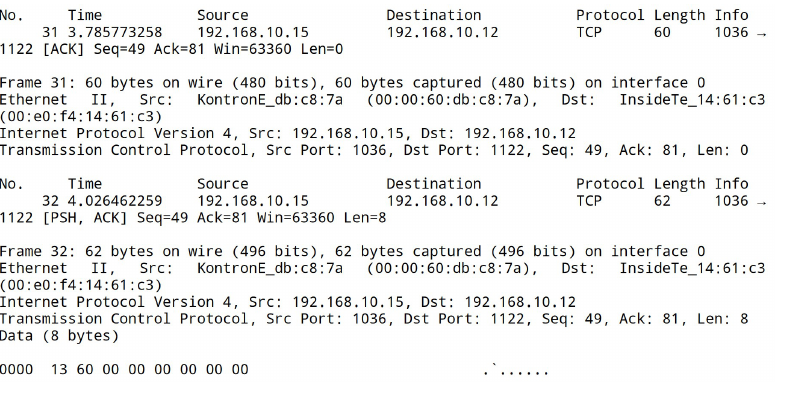
Figure 6. Sample of exported